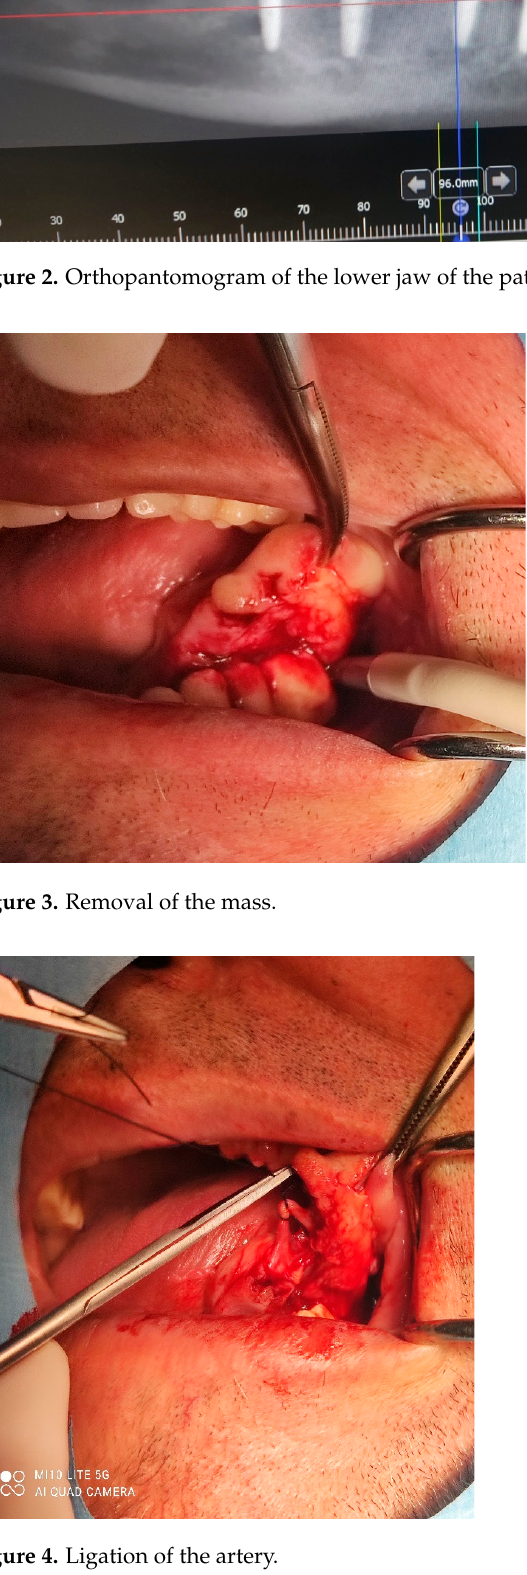
Figure 4. Ligation of the artery.